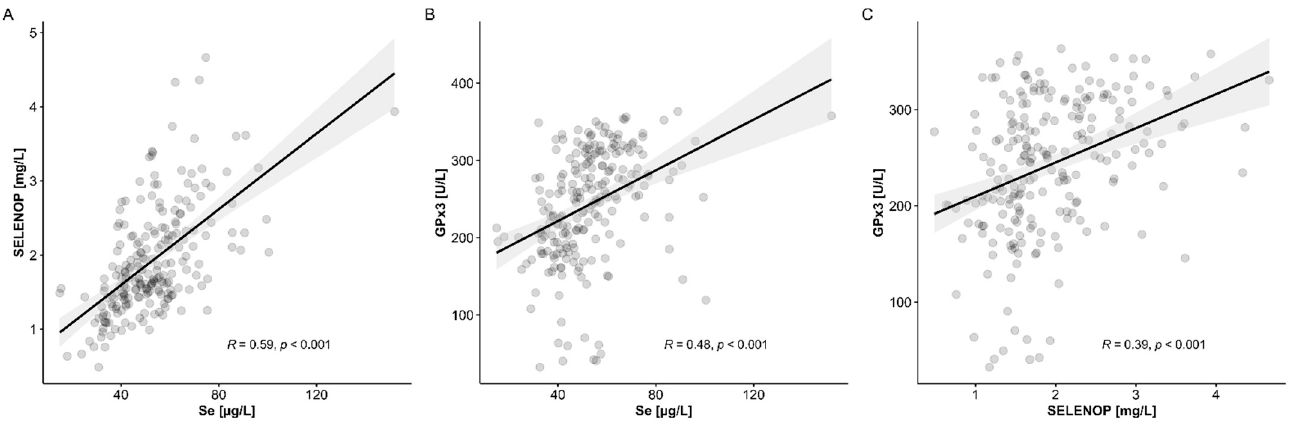
Figure 2. Interrelation of the biomarkers of Se status in the samples from patients undergoing LT. ( A ) Total serum Se and SELENOP concentrations showed a tight and linear correlation over the full range of data ( R = 0.59). ( B ) Similarly, extracellular GPx3 activity correlated positively and linearly to serum Se concentrations ( R = 0.48). ( C ) The two circulating protein biomarkers of Se status, i.e., SELENOP and GPx3, showed a moderate positive correlation in the samples analyzed ( R = 0.39); n = 221, R ; Spearman correlation coefficient (two-sided, two-tailed).